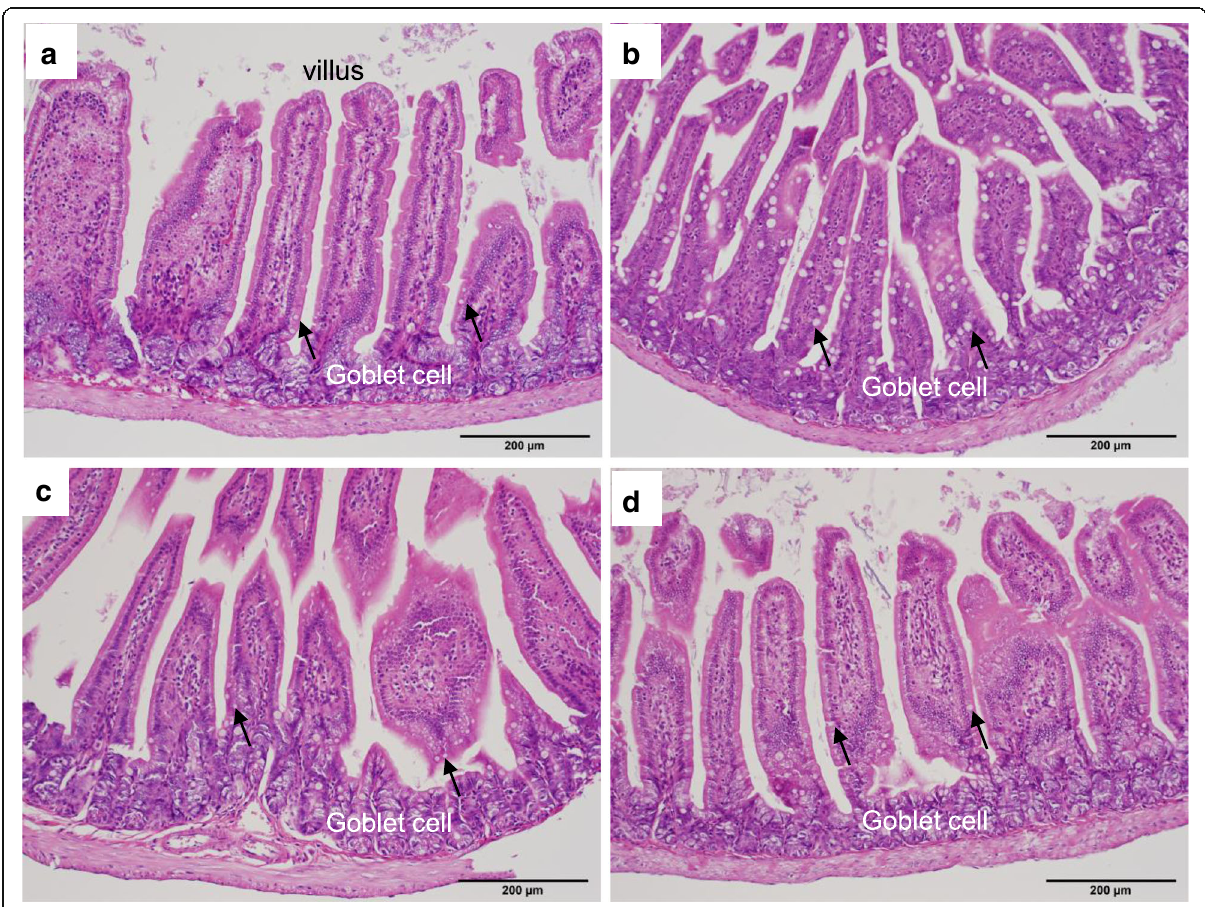
Fig. 7 Histopathology of the small intestine. H&E-stained small intestinal villi of a PbA-C57BL/6 mouse on day 8 and a PbA-BALB/c mouse on day 15 are shown with uninfected controls. a The villus of a control C57BL/6 mouse. b Enlarged villus goblet cells of a PbA-C57BL/6 mouse. c The villus of a control BALB/c mouse. d Villus goblet cells of a PbA-BALB/c mouse